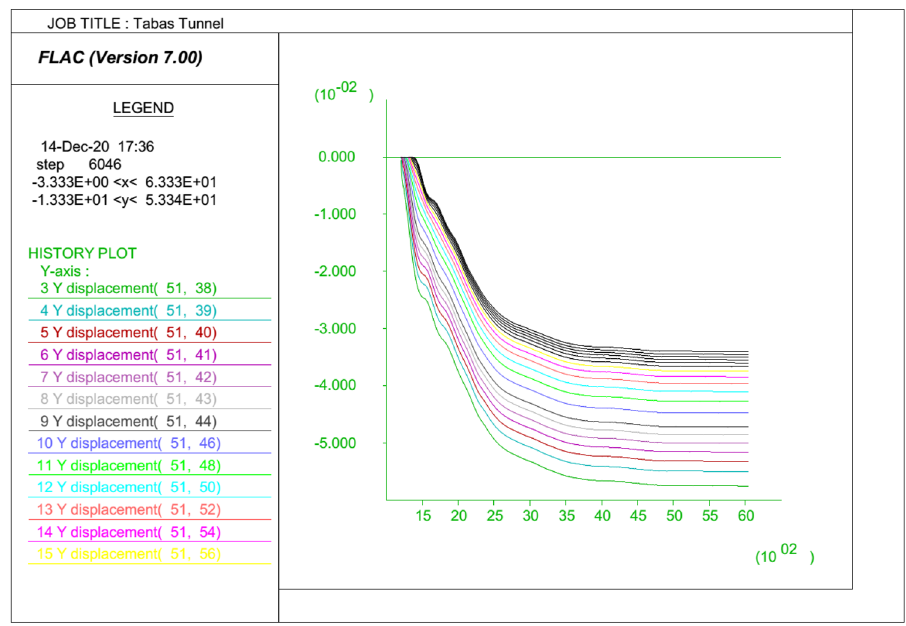
Figure 8. y-Displacement histories in specified gridpoints versus timestep for the selected